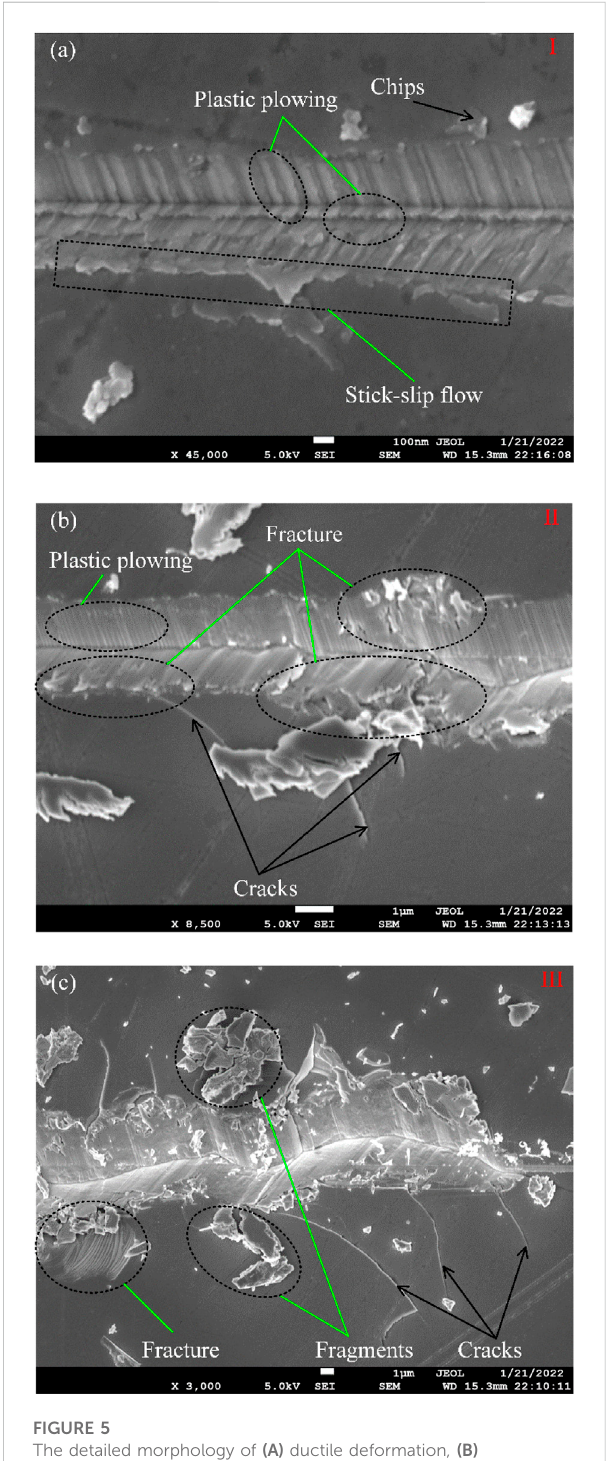
FIGURE 5 The detailed morphology of (A) ductile deformation, (B) transitional stage, and (C) brittle deformation.